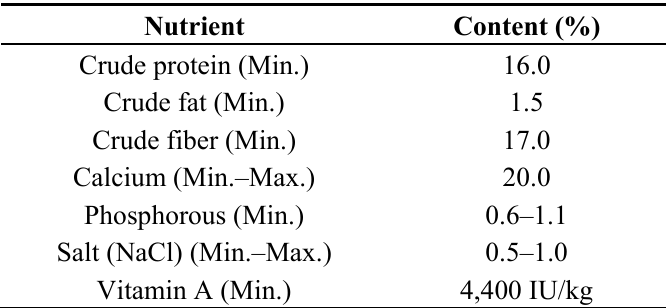
Table 8. Nutrient content of basal diet rabbit